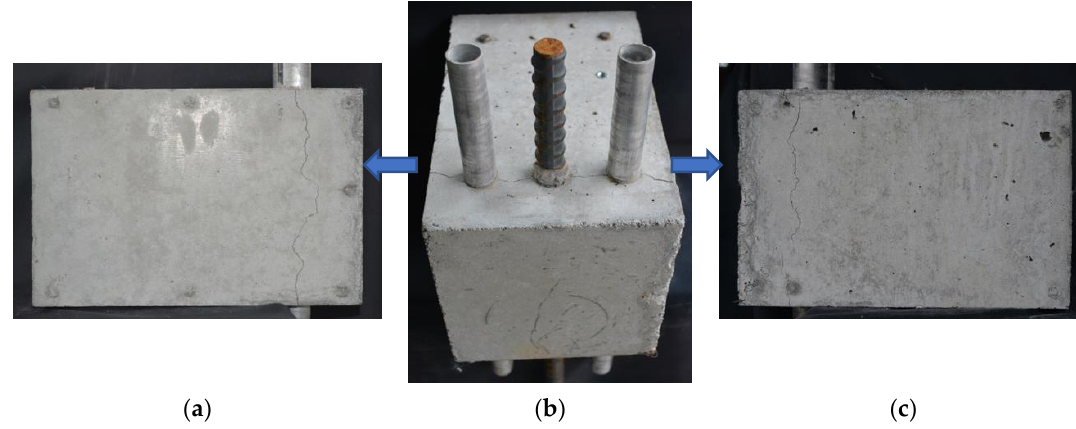
Figure 9. Specimen cracked by EAFP: ( a ) crack on specimen side; ( b ) crack on specimen top (considered crack with); ( c ) crack on other specimen sides.